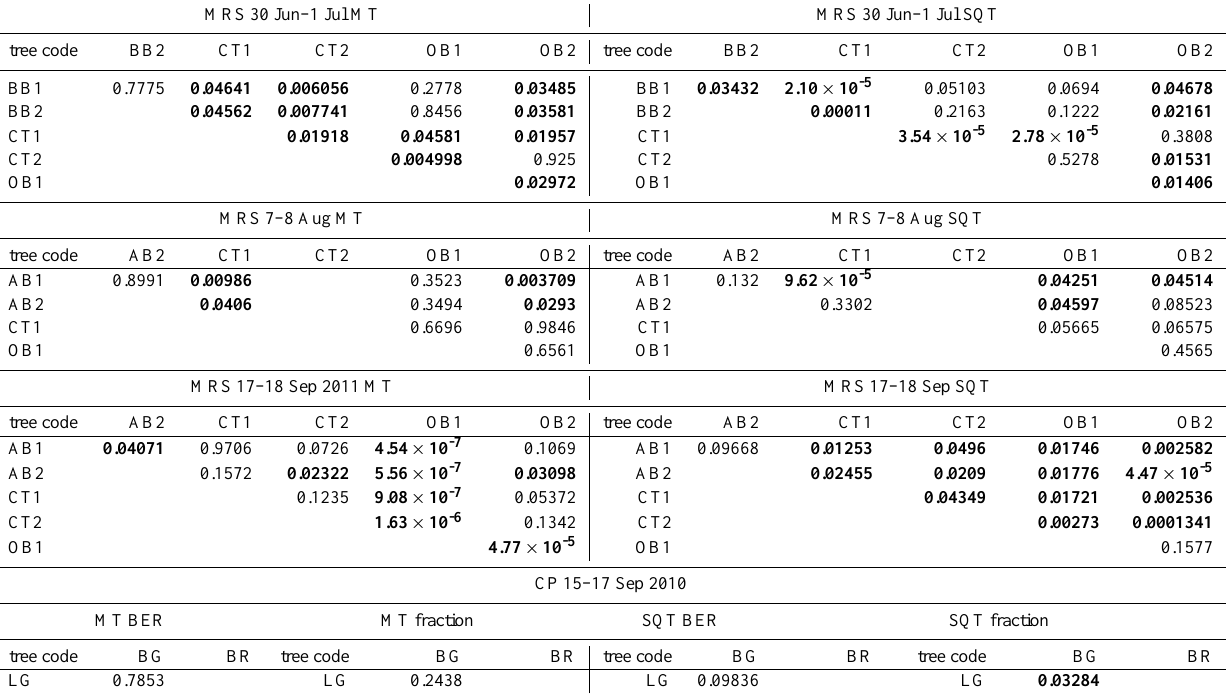
Table 6. Two-sided t-test results (reported as p-values) between individual tree MT and SQT BERs during the first, second, and third sampling visits at MRS, and between sampling classes at CP (bold lettering indicates significance at the 95% confidence level). The BR sample class at CP and August emissions from tree CT-2 at MRS were excluded from statistical analyses due to small sample